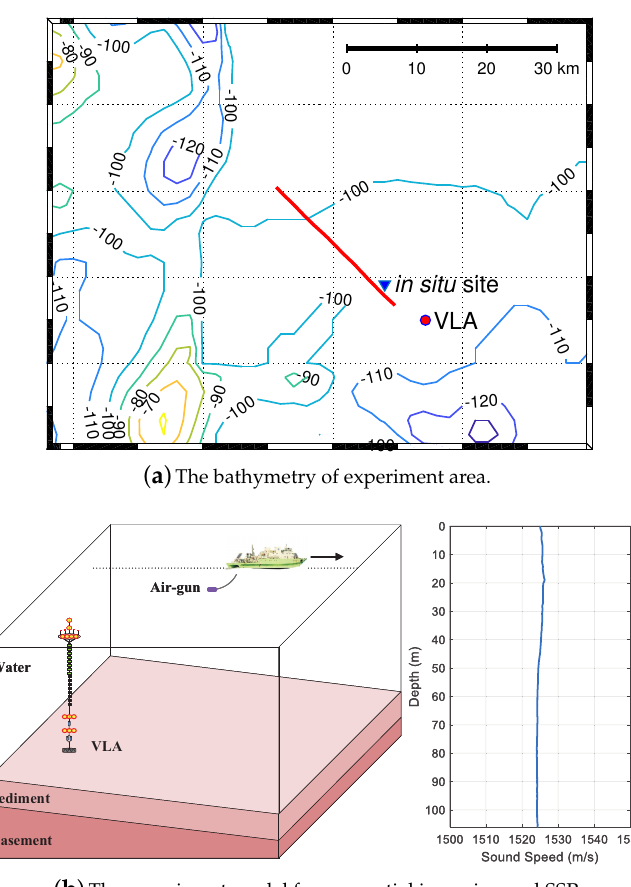
( b ) The experiment model for sequential inversion and SSP. Figure 4. The bathymetric data of experiment area and the environment model. ( a ) The VLA is labeled with a circle and in situ site is labeled with downward triangle. The full trajectory of ship is shown as a red line. Bathymetric data was obtained from ETOPO1. ( b ) left: the environmental model for sequential inversion, and the sea bottom consists of a sediment layer and a basement. Right panel shows the sound speed profile used in this work.